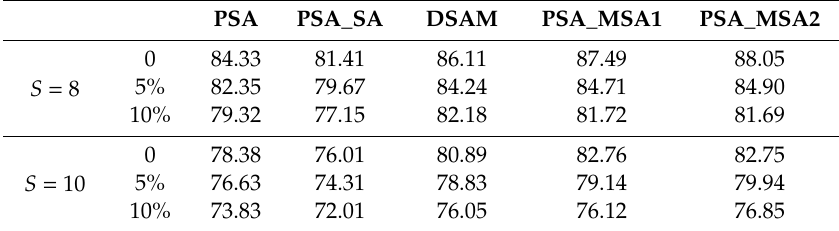
Table 10. Kappa values (%) with different numbers of errors for methods based on PSA.